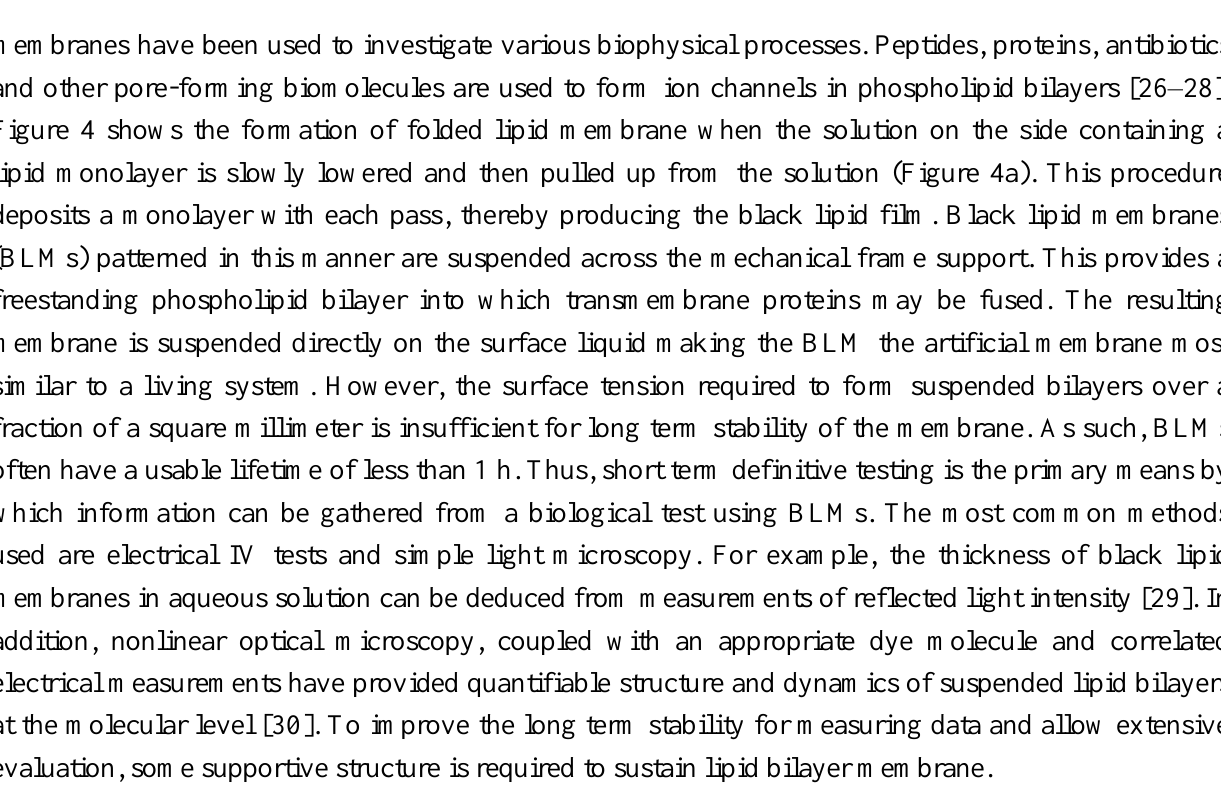
Figure 4. Black lipid membrane (BLM) deposition: ( a ) A single dip and pull of a mechanical support into water coated by a lipid results in a monolayer; ( b ) Lowering the substrate twice forms a BLM at the water